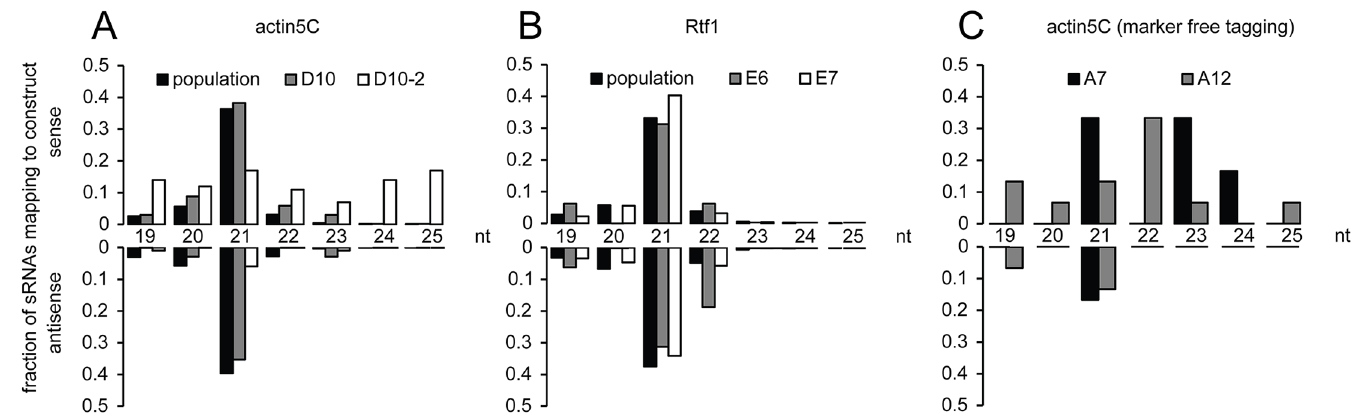
Fig 3. Read length distribution of act5C (A, C) and rtf1 (B) locus matching reads in sense and antisense orientation of representative cell lines. Data is presented as fraction of total siRNAs mappingto the construct. (Actin5C D10 = clone, D10-2 = FlpOut clone; Rtf1E6 and E7 = clones; Actin5C A7 and A12 = marker-free tagged